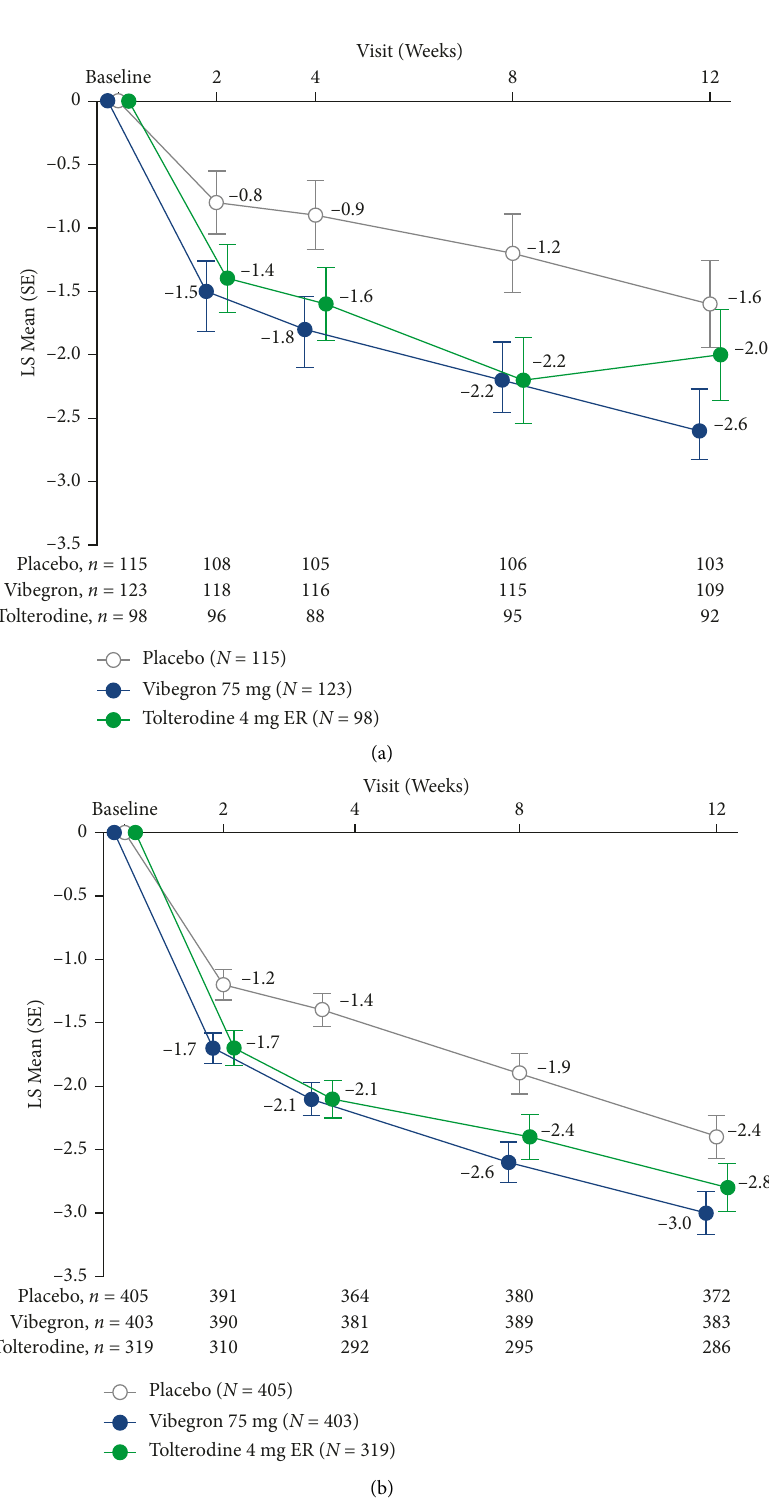
Figure 1: LS mean (SE) change from baseline in mean daily number of urgency episodes for patients with (a) OAB dry and (b) OAB wet. ER, extended release; LS, least